Question: Judging by this figure, is the value going up or going down?
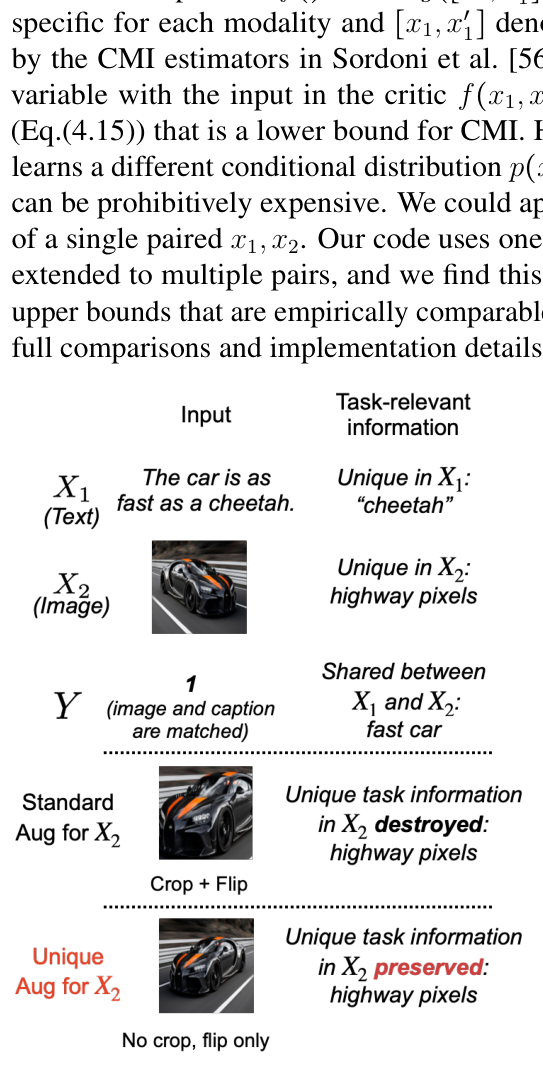
Answer: increasing